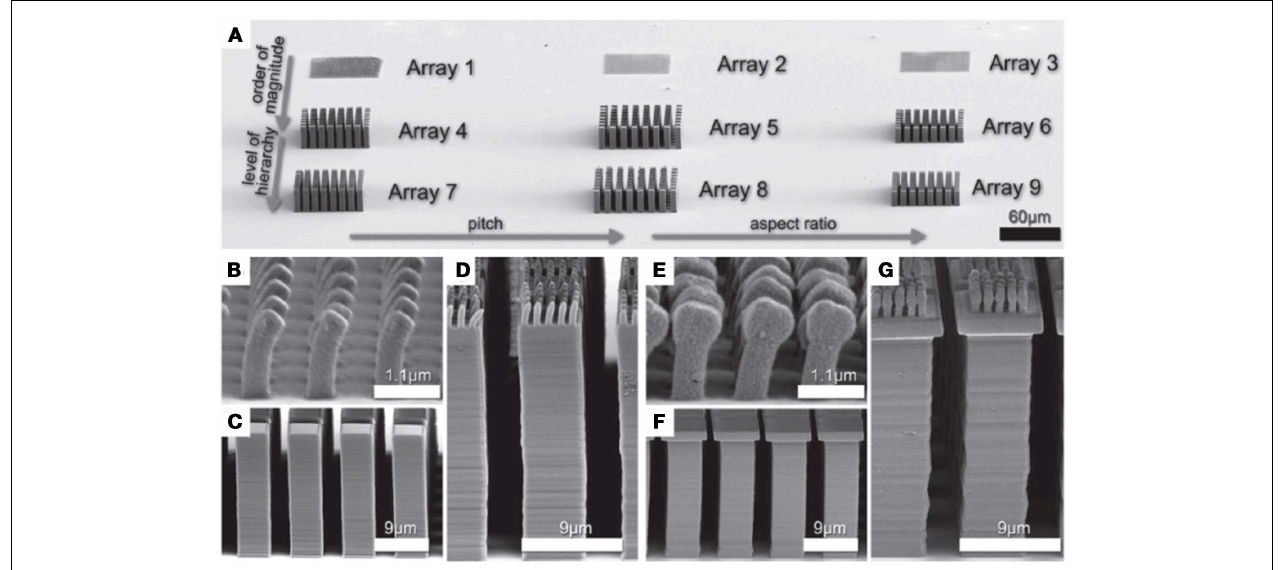
pillars of 5 µ m width. (D) Array 7 consists of the array 1 on top of array 4. (E–G) Show corresponding arrays with mushroom-shaped tips.The scale bars refer to the periodicity of the arrays (Röhrig et al.,